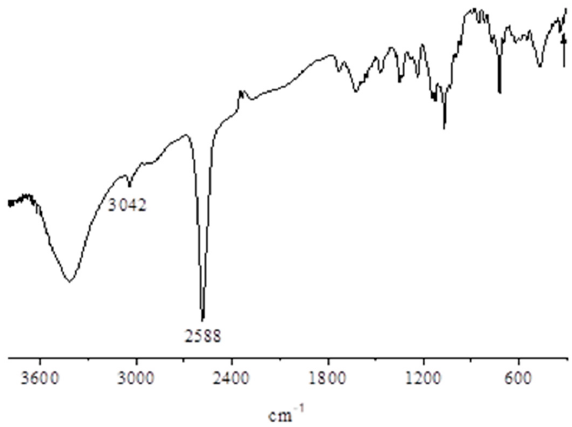
Figure 13. IR spectrum in KBr of the complex [{Pd(CBT 2 )} 4 Py 8 TPyzPzIn(OAc)] · 19H 2 O. The present pentanuclear CBT derivative, insoluble in H 2 O and in the nonaqueous solvents acetone, THF and CHCl 3 , dissolves better (c ~ 10 − 5 M) in DMSO, DMF and pyridine.